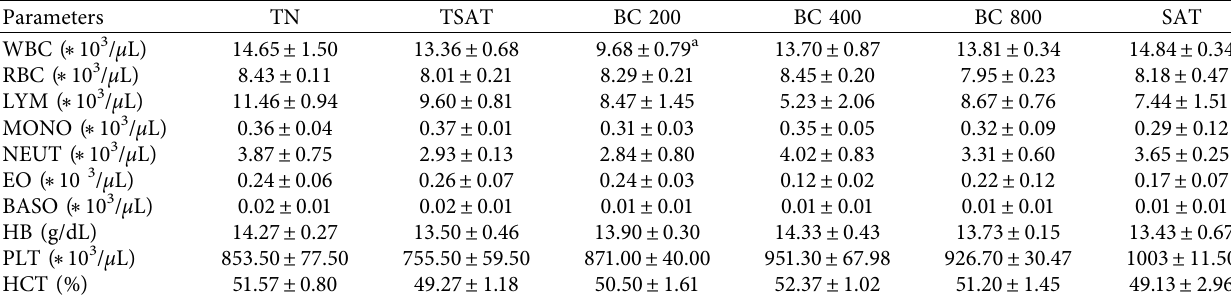
Table 6: Efects of the plant mixture aqueous extract on the blood elements in females. Parameters